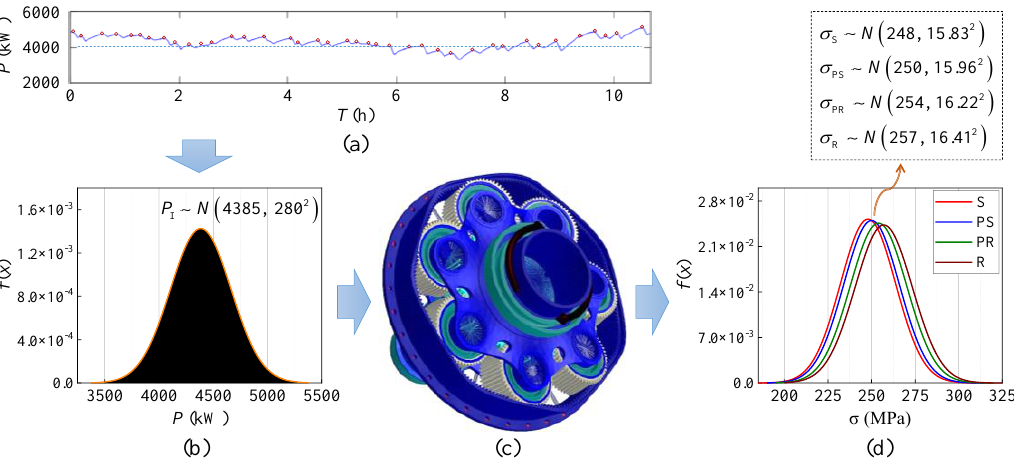
Figure 14. Load input variable conversion: ( a ) input power history; ( b ) power peak distribution; ( c ) hierarchical finite element simulation; ( d ) stress peak distribution.